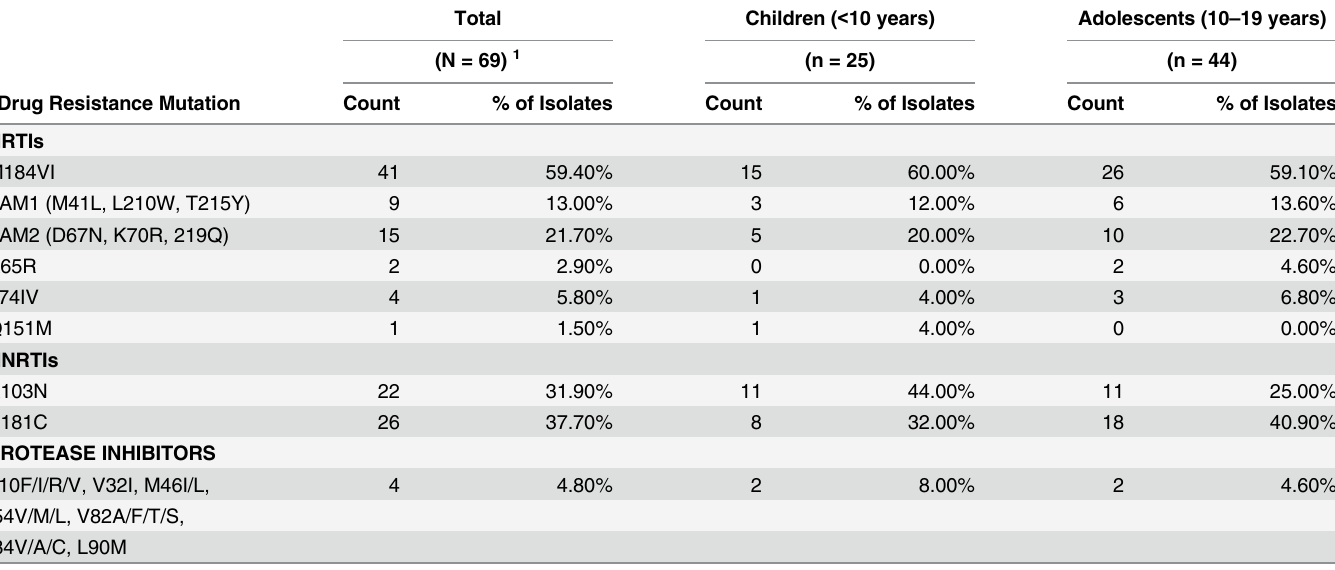
Table 4. Resistance mutations by age group at cross-sectional